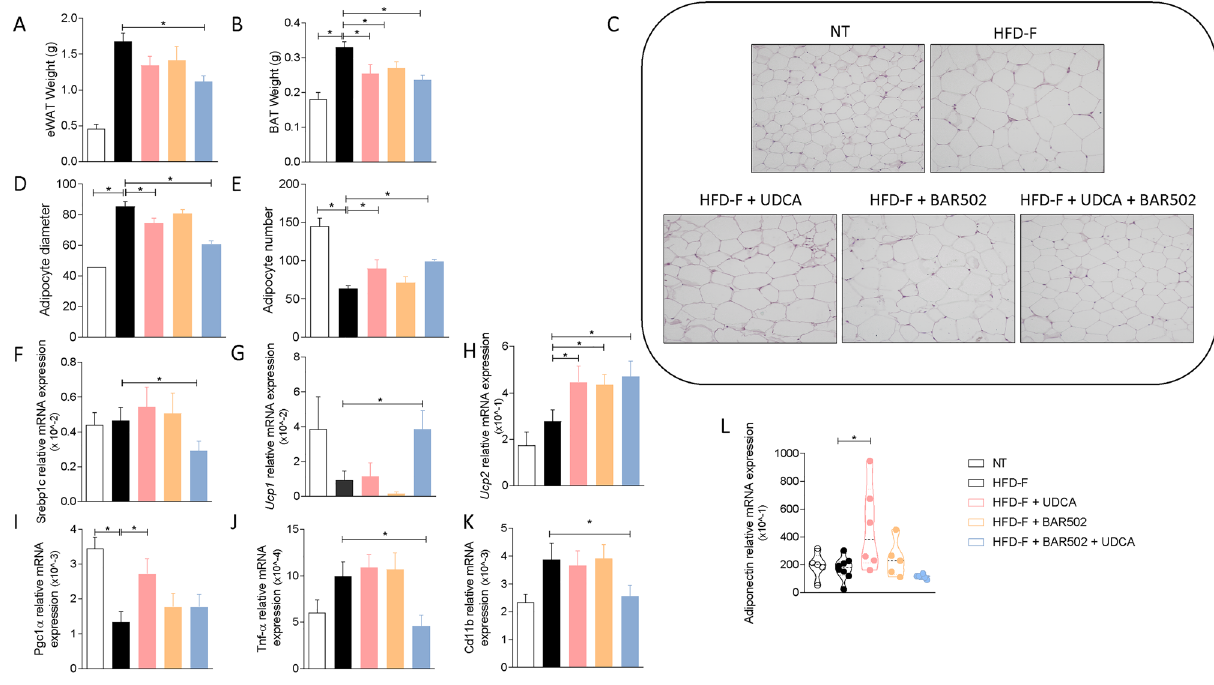
Figure 6. ( A ) Epididymal fat (eWAT) and ( B ) brown adipose tissue (BAT) weight, ( C ) H&E staining of eWAT tissues obtained at the end of the study. Original magnification × 40. ( D ) Adipocytes size and ( E ) number obtained from analysis of H&E staining performed with ImageJ. ( F – L ) Changes of mRNA expression of eWAT genes. The RT-PCR values were normalized against Gapdh. The data shown are the mean ± SE of 7–10 mice per group (*p < 0.05).